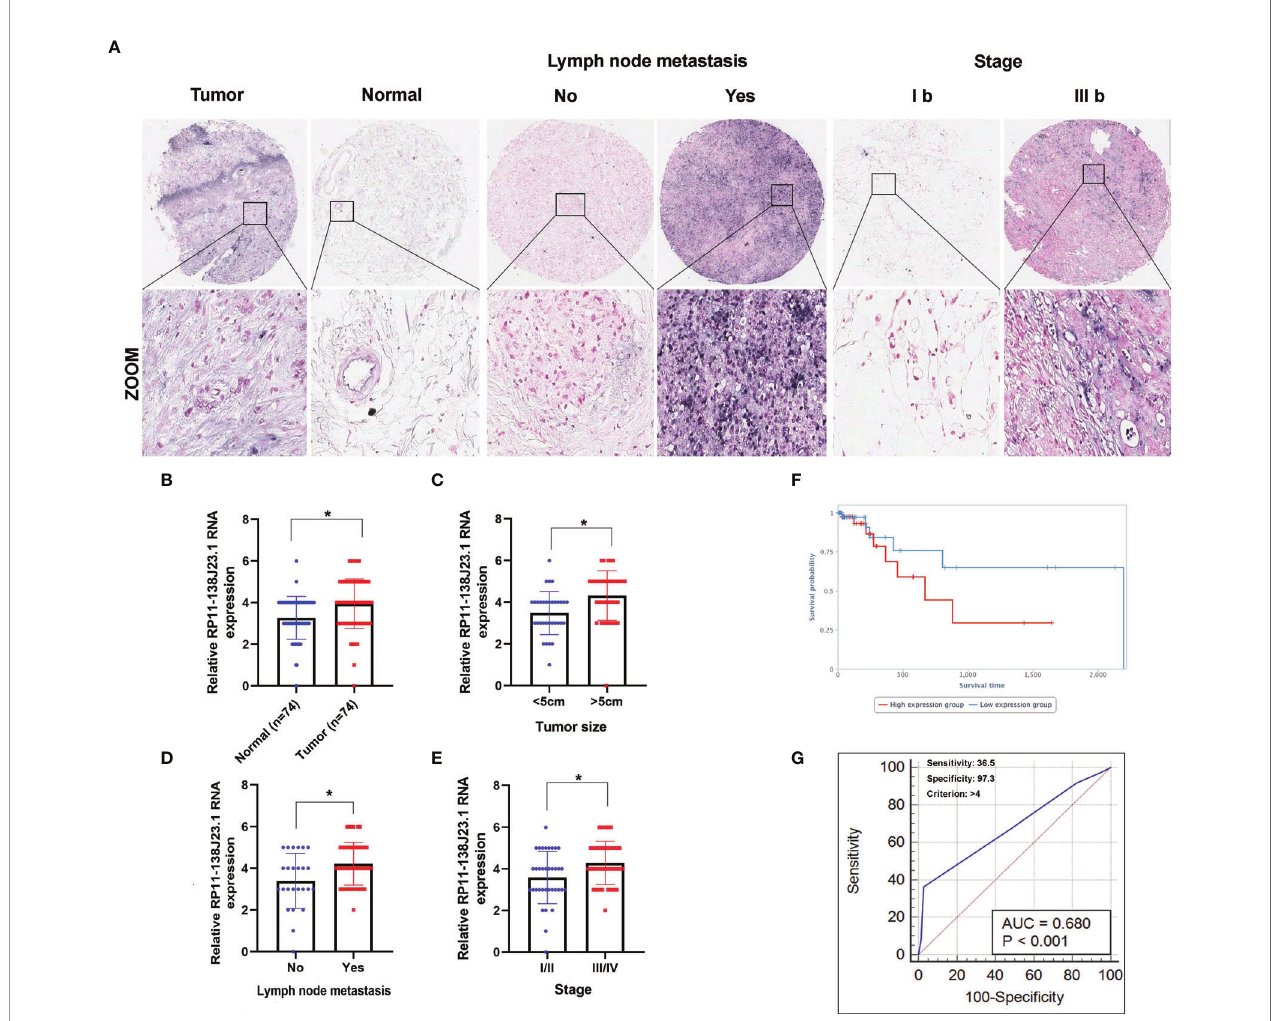
FIGURE 2 | Higher RP11-138J23.1 expression levels in GC and its clinical signi fi cance. (A) The RP11-138J23.1 expression level in 74 GC tissues and corresponding adjacent nontumor tissues was quanti fi ed by ISH analysis. (B) Histogram showing RP11-138J23.1 in situ hybridized expression of paired adjacent nontumor tissue and GC tumors. (C – E) The relationship between RP11-138J23.1 expression and clinicopathological parameters (such as maximum diameter, lymphatic metastasis, and TNM stage) was shown. (F) Kaplan-Meier survival plots demonstrated that higher RP11-138J23.1 abundance correlated with a poor OS using the TCGA datasets. (G) The ROC curve for prediction of GC based on the expression level of RP11-138J23.1, using paired adjacent nontumorous tissues as a control. * p <